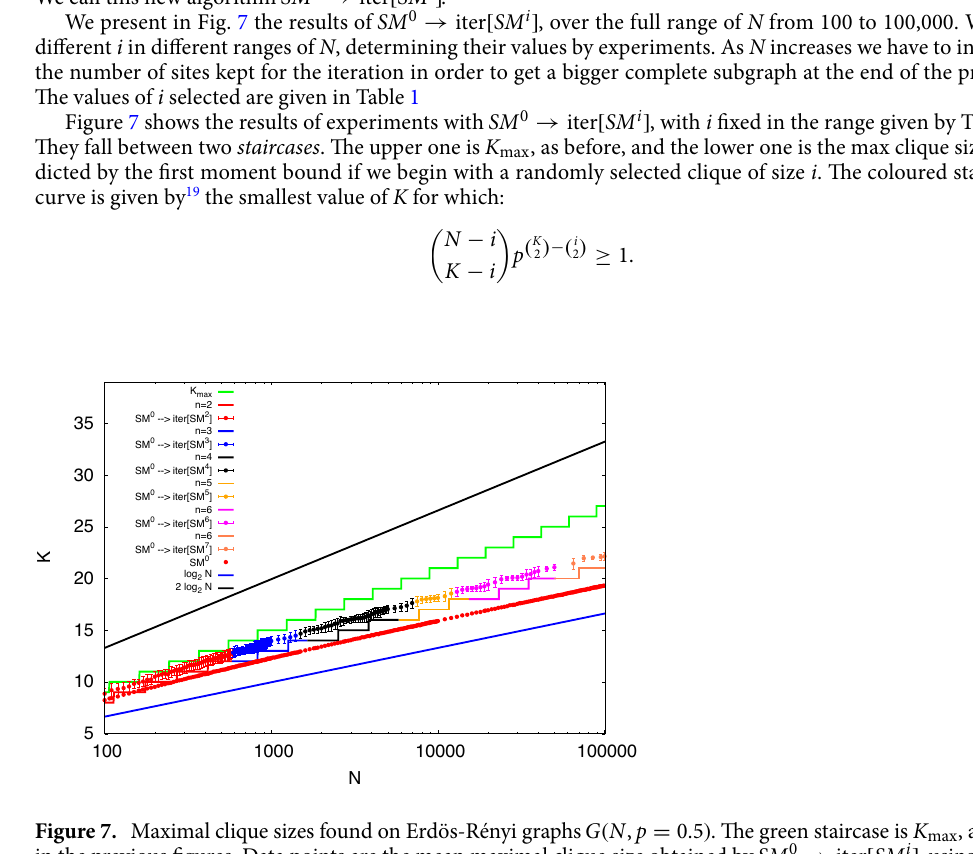
Figure 7. Maximal clique sizes found on Erdös-Rényi graphs G ( N , p in the previous figures. Data points are the mean maximal clique size obtained by SM 0 values of i given by Table 1. The multi-coloured staircase represents the expected maximum values of completed subgraphs conditioned by the fact that we are starting with an arbitrary complete subgraph of size i